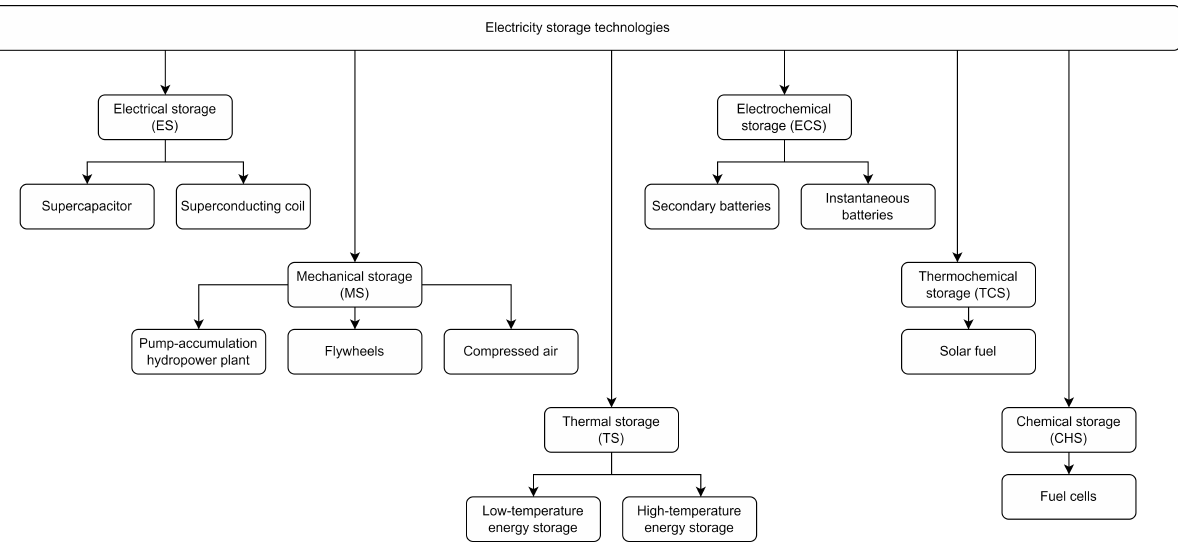
Figure 6. Overview and division of electricity storage